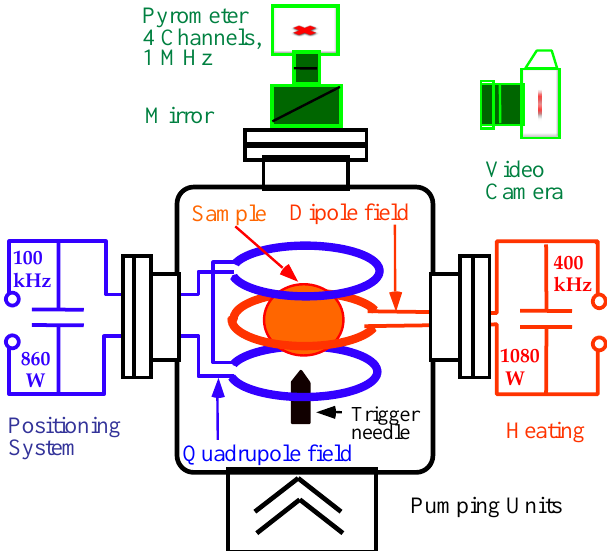
Figure 18. Schematic view of the TEMPUS facility. All subsystems are shown with the exception of the radial temperature